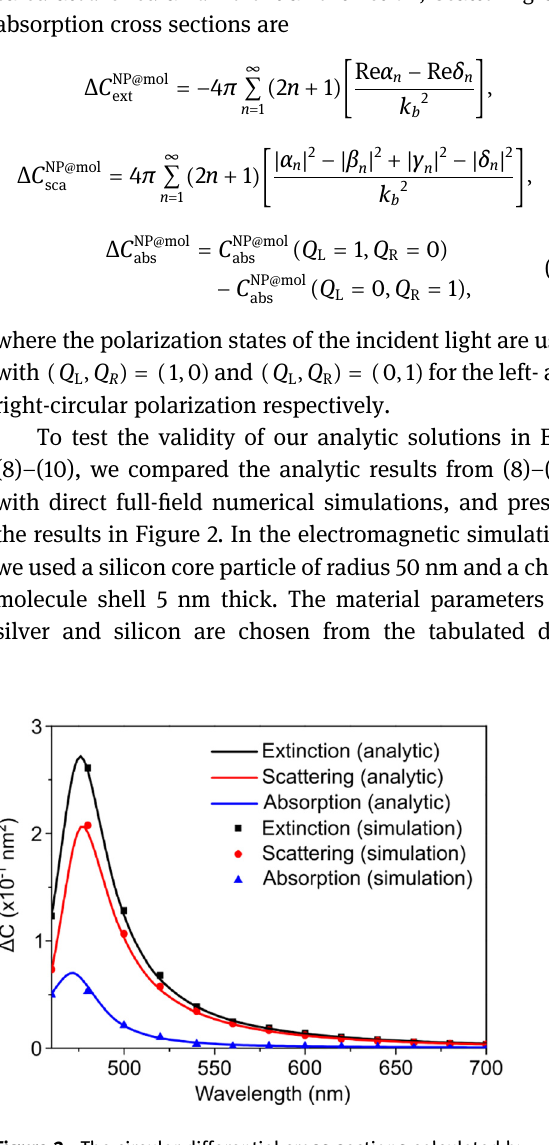
Figure 2: The circular differential cross sections calculated by analytic solution and numerical simulation. The results obtained by the two methods are perfectly